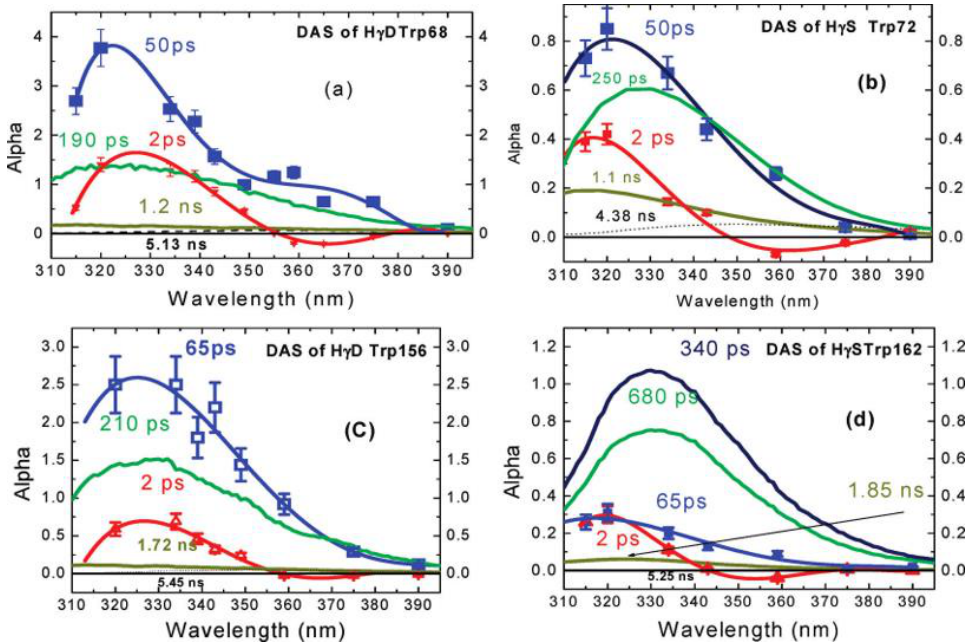
Figure 9. Decay associated spectra of tryptophan in four single-tryptophan mutants of crystallin. Image reproduced from Journal of the American Chemical Society 131 (2009) 16751.